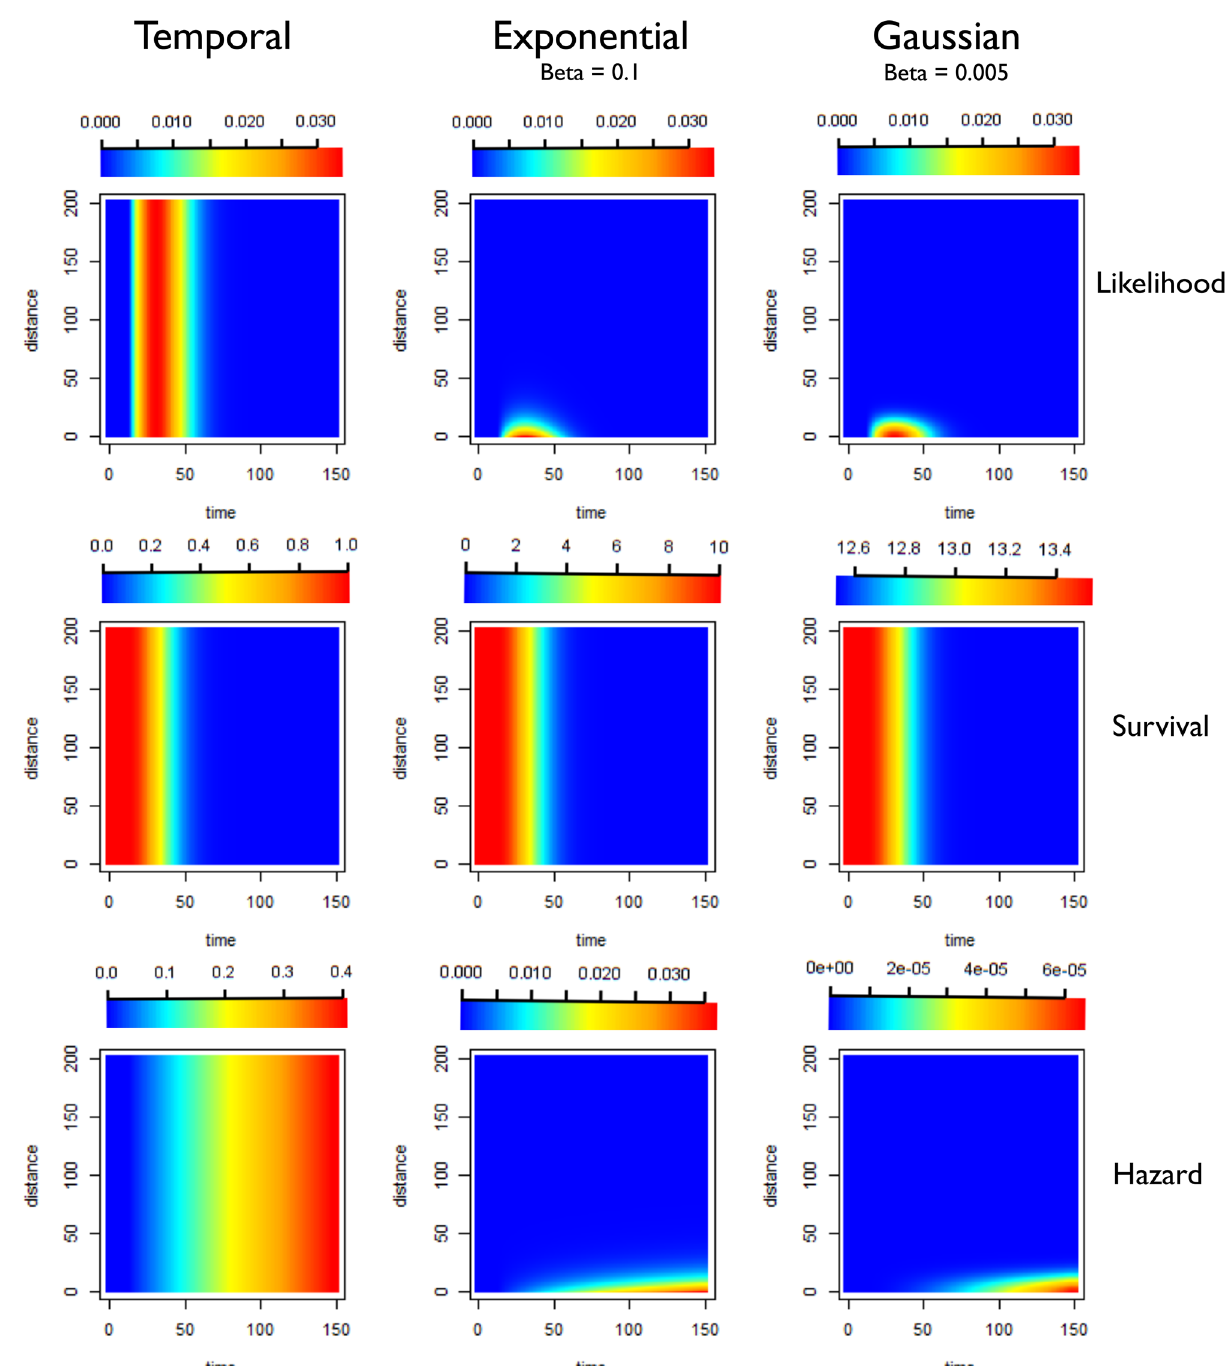
Figure 15. Illustration of likelihoods, hazards and survivals for highly restrictive kernels (Human movement unlikely, most movement under 10 km). Plots showing how the pairwise likelihoods, survivals and hazards vary with time and distance under different model structures. The first row of plots shows the pairwise likelihoods, the second row shows the pairwise survival and the third row shows the pairwise hazard values for different combinations of distance (in kilometres) and time between symptom onset (days). The first column shows the results for a time-only version of the algorithm. The second column shows results for an exponential kernel and the third column shows results for a Gaussian kernel. In this example more restrictive values for beta, the shaping parameter for the distance kernels have been chosen, representing a context where there is very little movement of parasites, with very little movement beyond 10–20 km